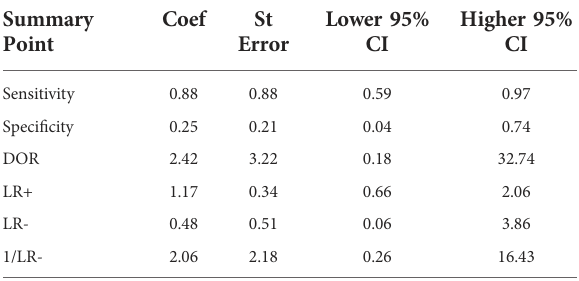
TABLE 6 Summary statistics for intravenous Indocyanine Green localization. Summary